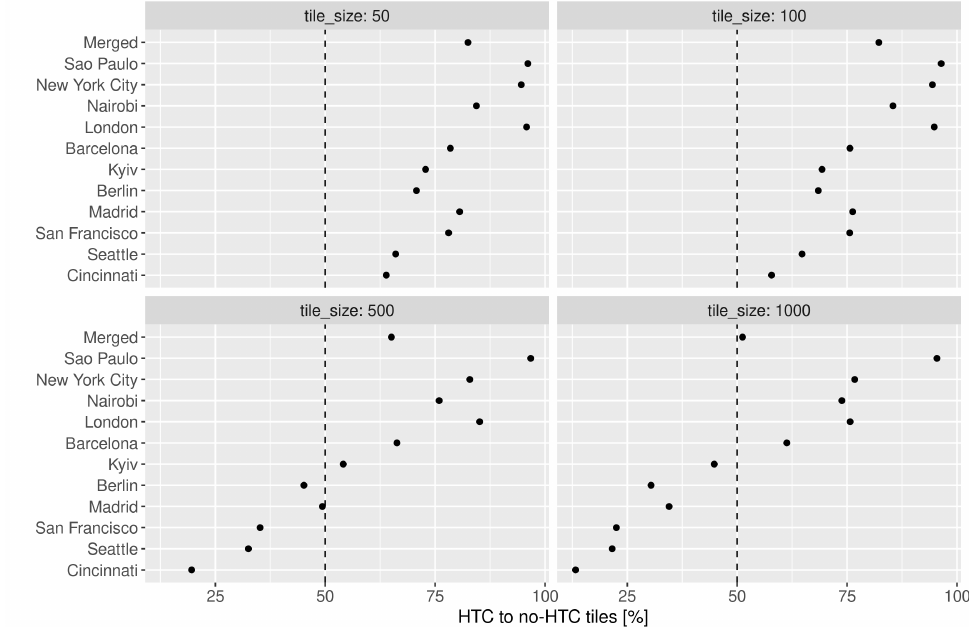
Figure 6. Degree of class imbalance in HTC vs. no-HTC labels per each dataset based on the Uber data (static class definitions). All instances with at least one empty feature space have been discarded. The x-axis shows the relationship between the number of HTC to no-HTC tiles per city for the different tile sizes. A value of 50% indicates perfectly balanced data. “Merged” represents the combination of all eleven